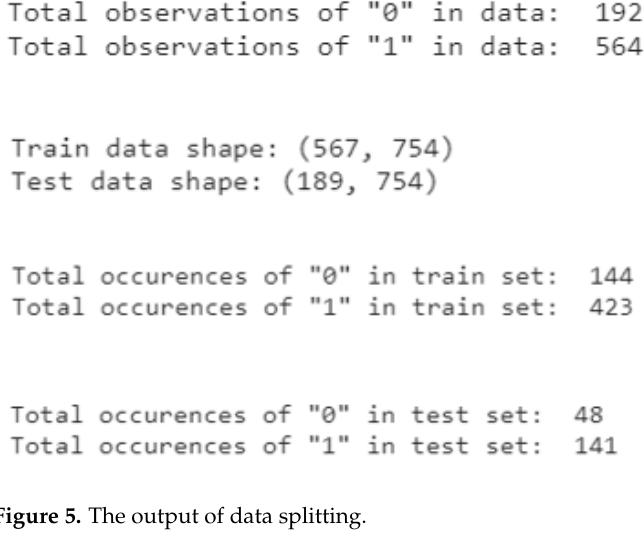
Figure 4. The output of data standardization. The feature data shape (756, 754) is split into train data and test data, with a ratio of 75/25. Hence, the data size of the train set is (567, 754), and that of the test set size is (189, 754) which are illustrated in Figure 5. Additionally, the feature data is split in a stratified manner, which reserves the proportion of labels 0 and 1 from the feature data in both train and test sets: